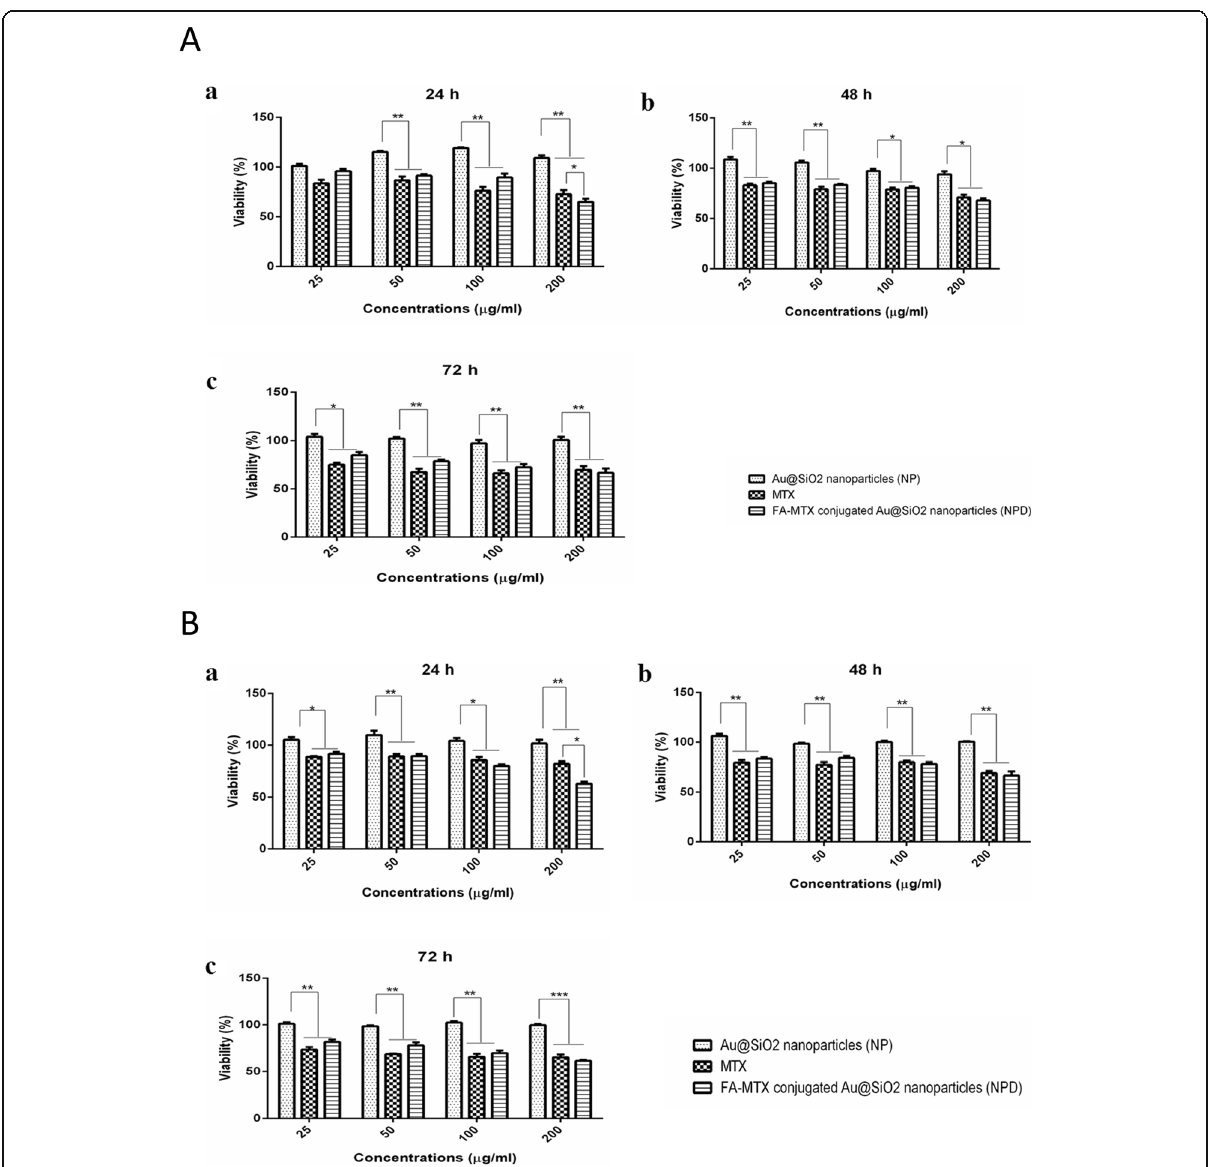
Fig. 6 a MCF-7 and ( b ) MDA-MB-231 cells growth inhibition rates after treatment with different concentration of NP, MTX and FA-MTX loaded Au@SiO 2 nanoparticles (NPD) after exposure time of 24, 48 and